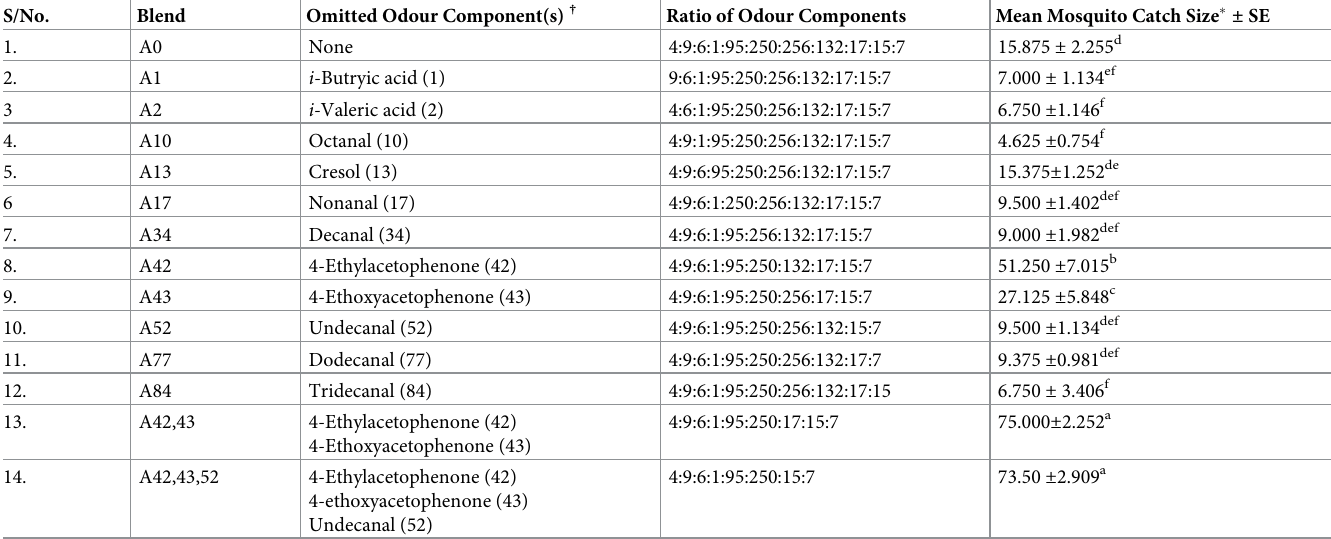
Table 1. Compositions of the artificial blends of EAG-active components of human odor and mean mosquito catch sizes.